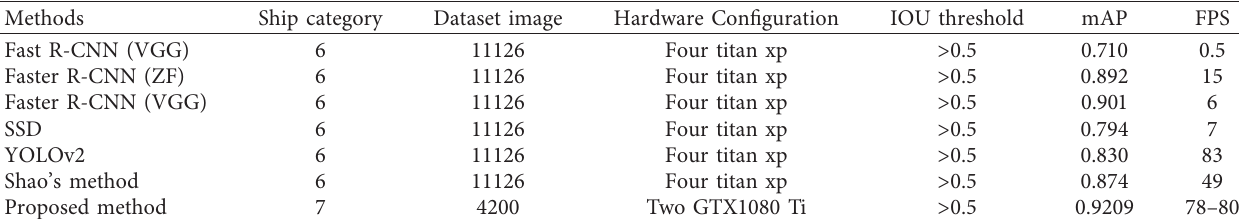
Table 6: The comparison with other intelligent detection and classification methods.